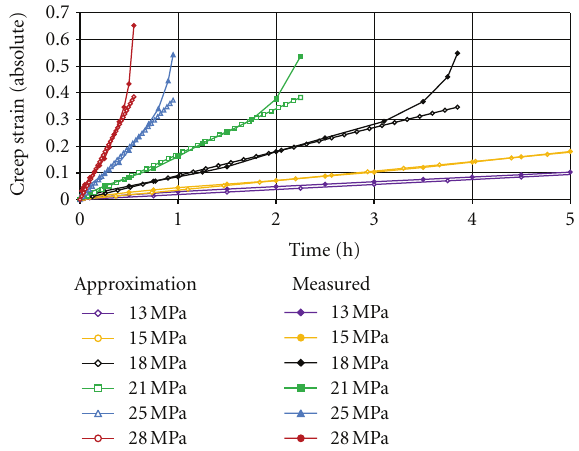
Figure 4: Linear approximation of measured creep curves (load controlled) of steel 20 MnMoNi 55 at 1000 ◦